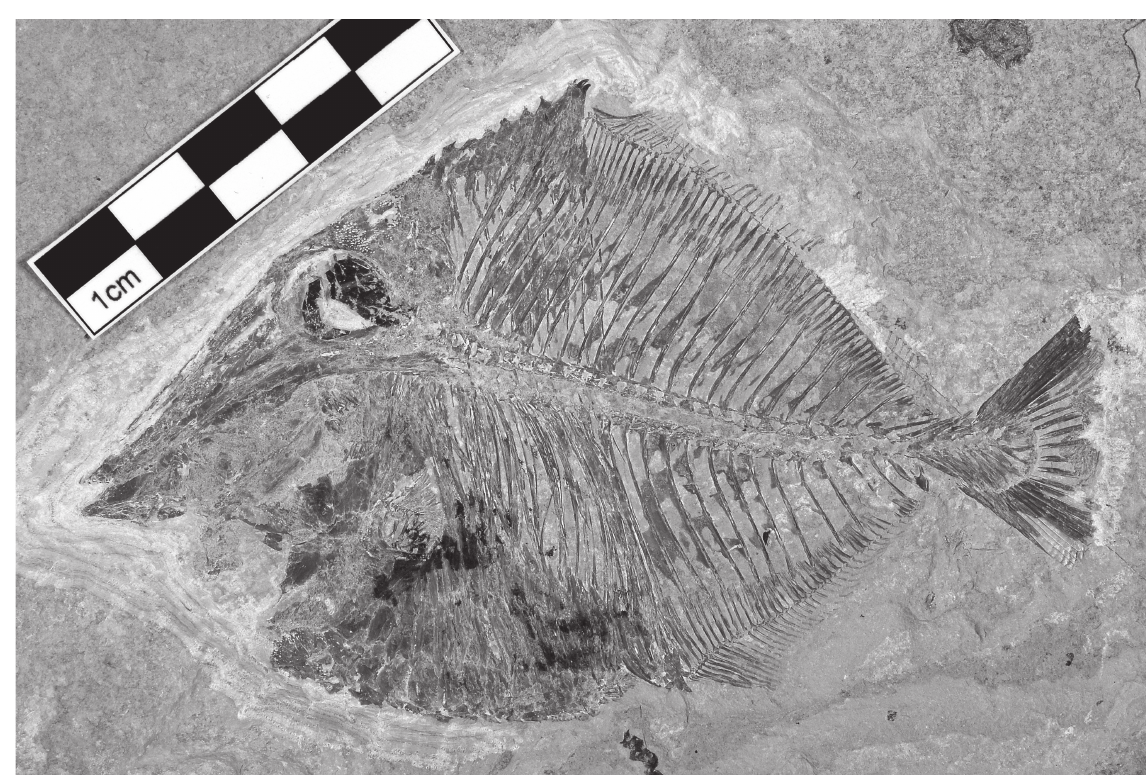
Fig. 3. Acrorhinichthys poyatoi gen. et sp. nov. Paratype CLC